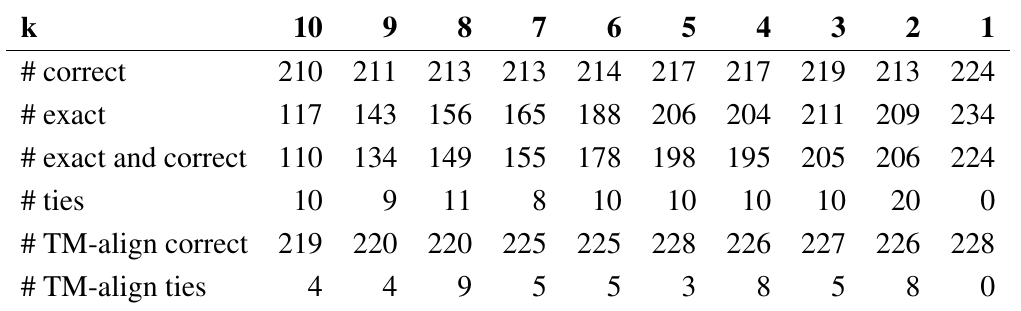
Table 2. Classification results showing the number of queries out of the overall 236